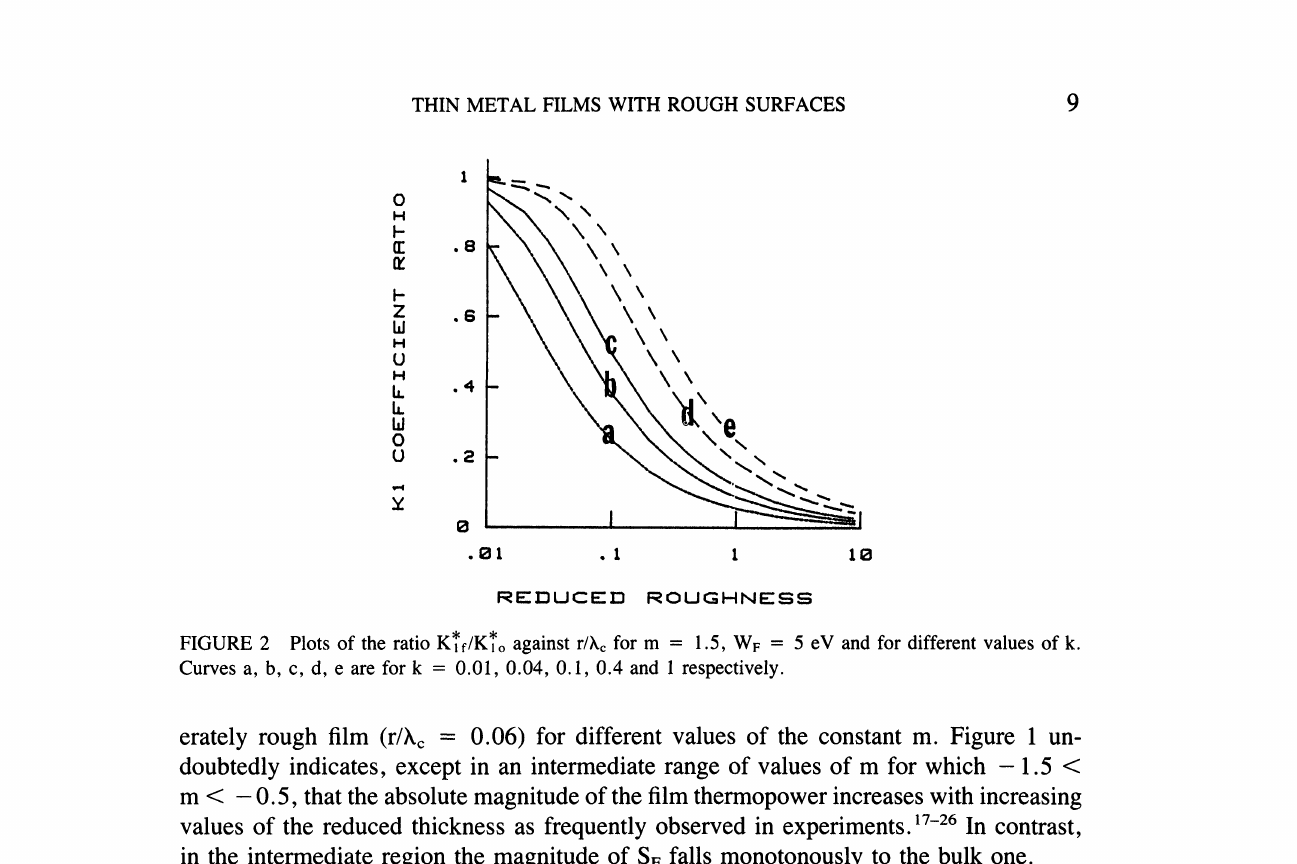
1.5, WF 5 eV and for different values of k.